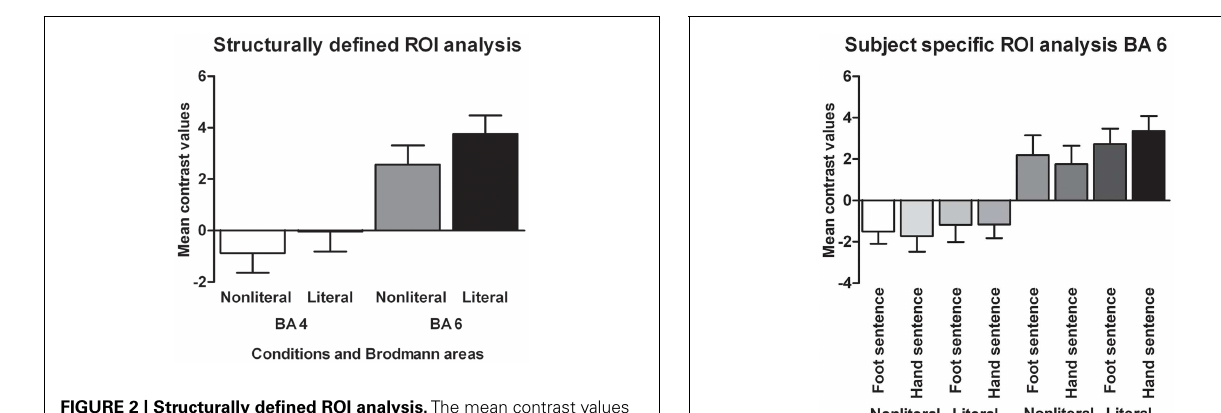
FIGURE 2 | Structurally defined ROI analysis. The mean contrast values compared to an implicit baseline are shown for each Brodmann area and sentence type.